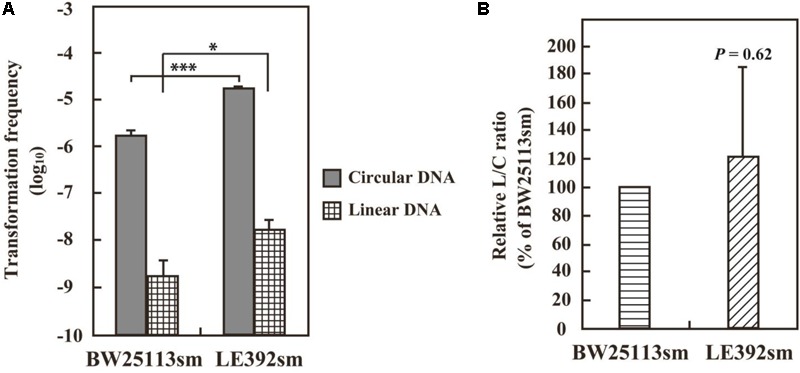
DNA transformation frequencies of E. coli strains BW25113sm and LE392sm. E. coli cells were electroporated with 50 ng circular pSRK-R316 and linear pSRK-R316 DNA fragments amplified by PCR. Transformation frequency (A) is defined as the number of transformants per μg DNA divided by the viable cell number. Single and triple asterisks indicate significant difference (P < 0.05 and P < 0.001, respectively) by Welch’s t-test. (B) The L/C transformation ratio was expressed as the ratio of the transformation frequency obtained with the linearized plasmid (L) divided by that using the circular plasmid (C). Statistical analysis was carried out using one-sample t-test against 100%.